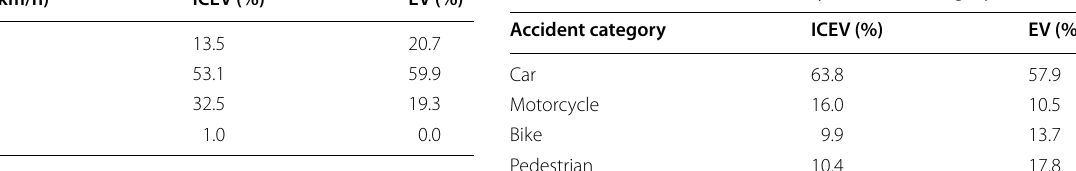
Table 7 Distributions of crashes by accident